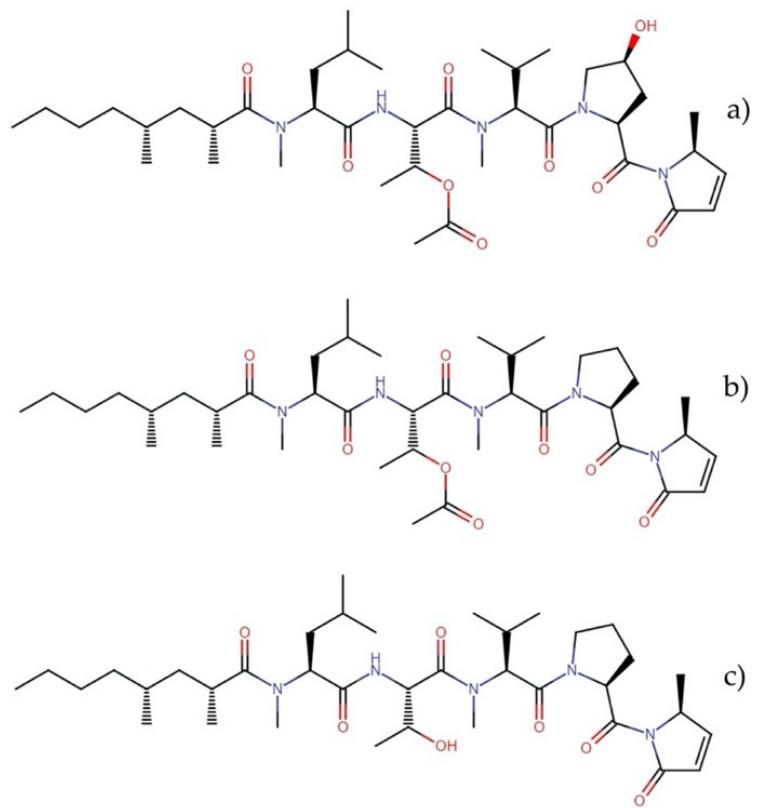
Figure 14. Chemical structures of ( a ) microcolin A, ( b ) microcolin B, and ( c ) deacetylmicrocolin B. Microcolins A–M induce significant cytotoxicity against NCI-H460 human lung cancer cells, with IC 50 values ranging from 6 nM to 1 µ M, microcolin A being the most cytotoxic molecule of this family against this cell line [107]. On the other hand, microcolins A and B and deacetylmicrocolin B inhibit HT-29 and IMR-32 cell growth, with IC 50 values ranging between 0.28 and 14 nM [108].